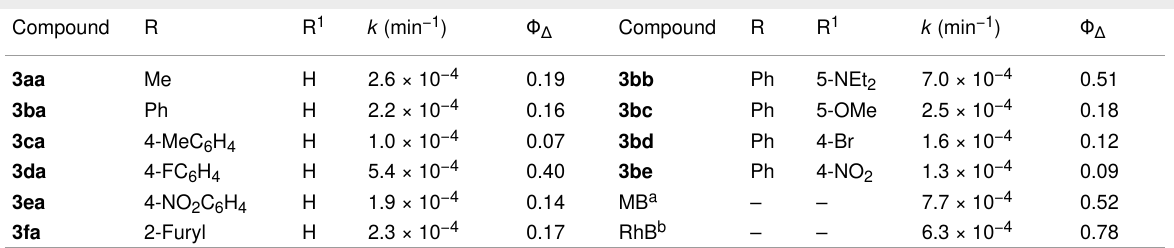
Table 2: Photooxidation rate constants and singlet oxygen quantum yield of compounds 3aa – fa and 3bb – be in DMSO solution. Compound